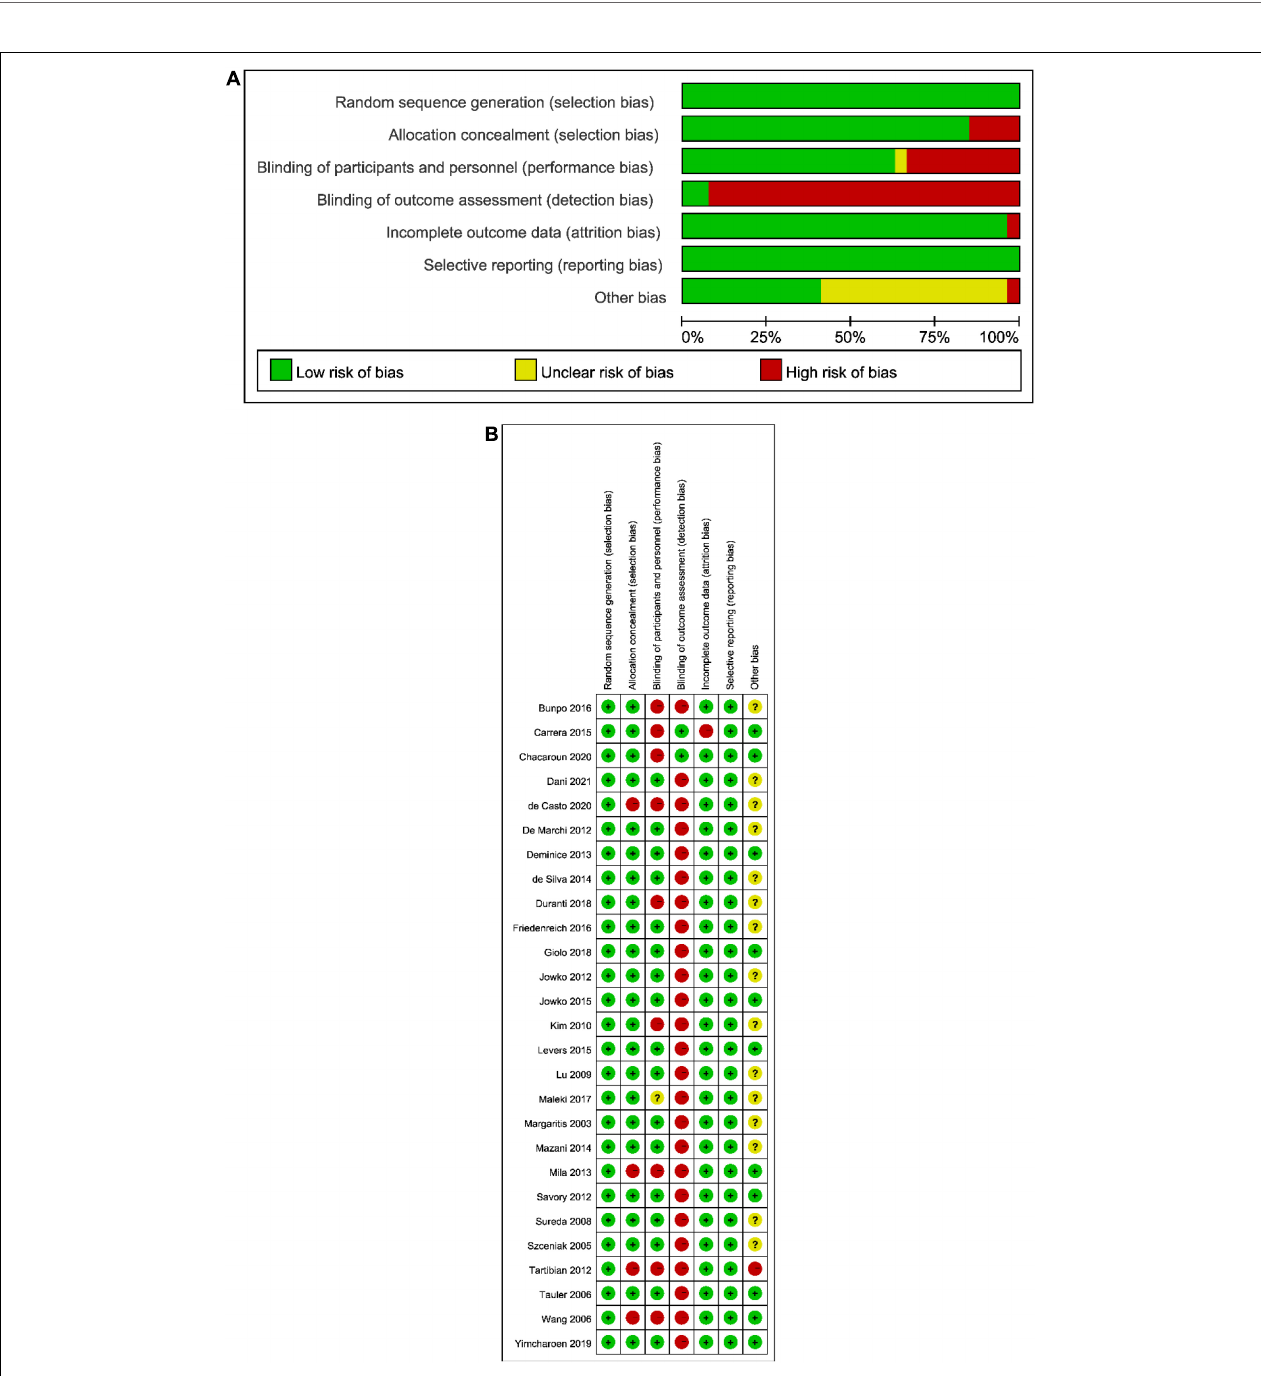
FIGURE 2 | The result of the risk of bias assessment. (A) Risk of bias graph; (B) Risk of bias